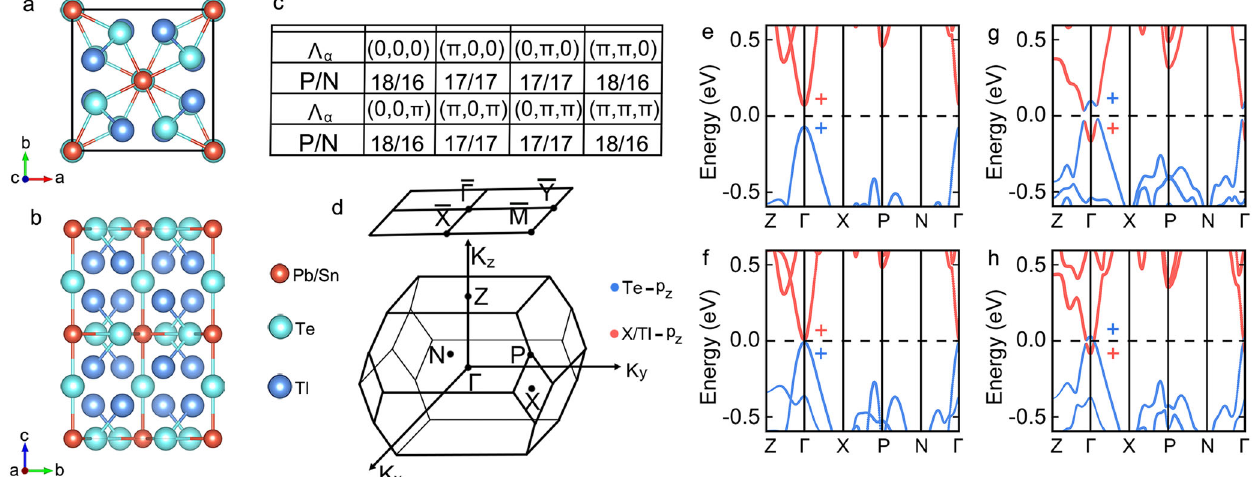
Fig. 2 Material candidates of wallpaper fermion and third-order topological insulators. a Top and b side views of Tl 4 X Te 3 ( X = Pb/Sn) conventional unit cell. c Numbers of occupied bands with positive (P) and negative (N) parities at eight T -invariant momenta ( Λ α ) with SOC. d Brillouin zone for the primitive unit cell of Tl 4 X Te 3 , and projected 2D (001) Brillouin zone. e – h Bulk band structures of e, g, Tl 4 PbTe 3 and f, h, Tl 4 SnTe 3 e, f, without and g , h with SOC. The bands are orbitally weighted with the contribution of Te- p z and X /Tl- p z states. The Fermi level is indicated with a dashed